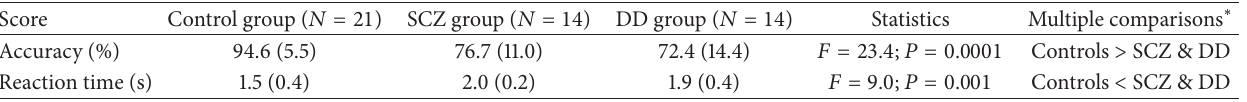
Table 2: Mental rotation performance in schizophrenia and dual-diagnosis patients and healthy controls.